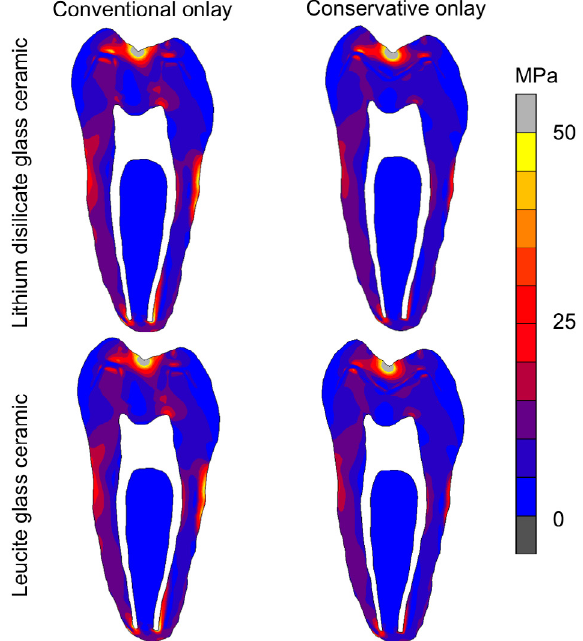
Figure 4- Modified von Mises stress distributions for all groups at 100 N. (A) Conventional onlay/ lithium disilicate glass ceramic; (B) Conventional onlay/leucite glass ceramic; (C) Conservative onlay/lithium disilicate glass ceramic; (D) Conservative onlay/ leucite glass